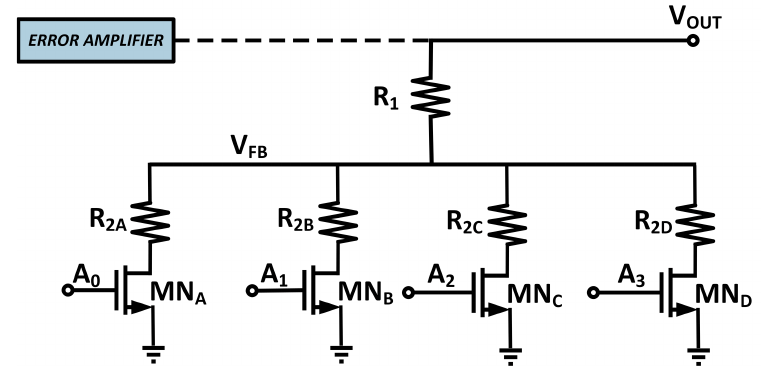
Figure 4. Feedback resistor design of